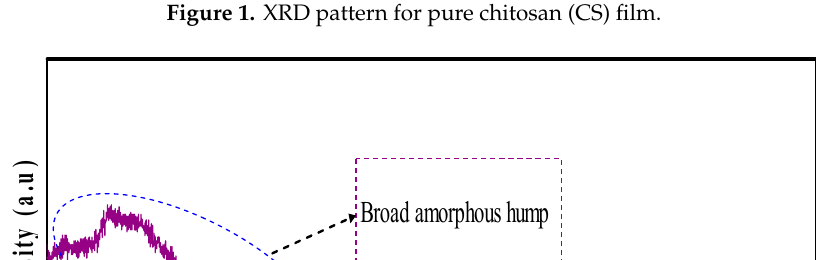
Figure 2. XRD pattern for chitosan: poly (2-ethyl-2-oxazoline) (POZ) polymer blend film.